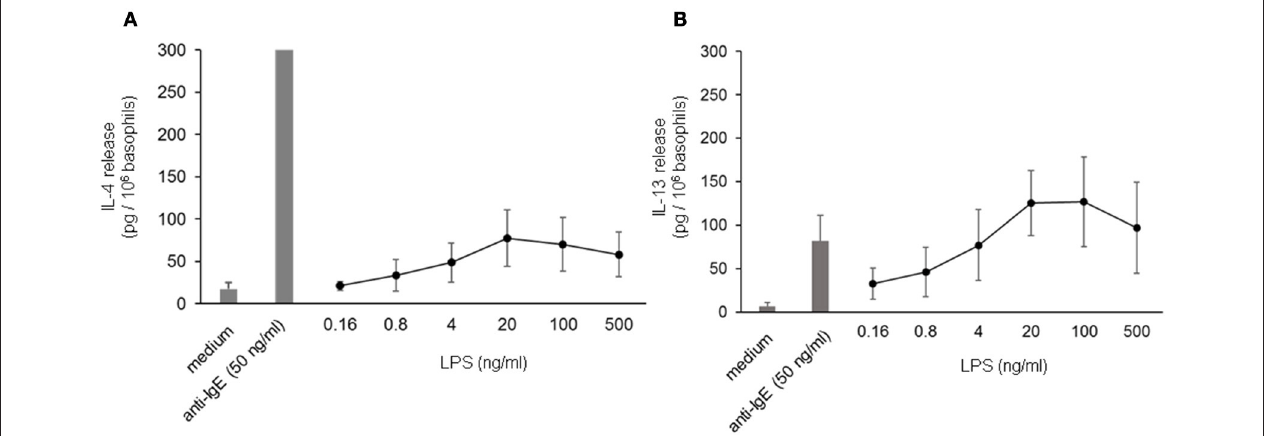
FIGURE 8 | IL-4 and IL-13 release from basophils following stimulation with LPS. IL-4 (A) and IL-13 (B ) release from basophils stimulated with different concentrations of LPS in comparison to anti-IgE. All stimulations were performed in the presence of IL-3. Data are presented as mean ± SEM; (A) n = 7, (B) n = 5.